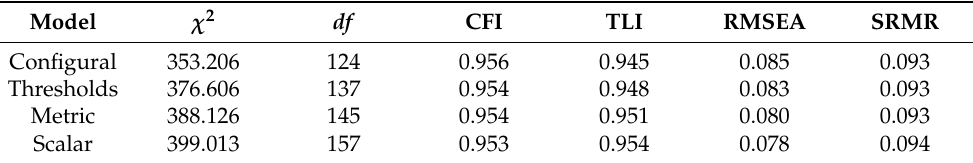
Table 3. Measurement of invariance across